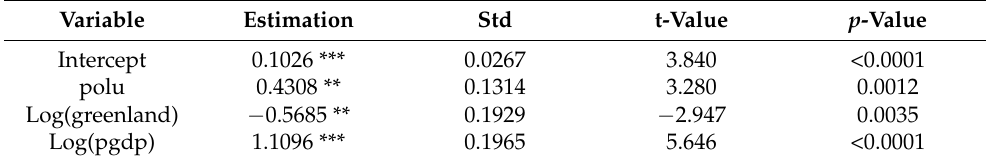
Table 6. The linear effect result of environmental status on mortality